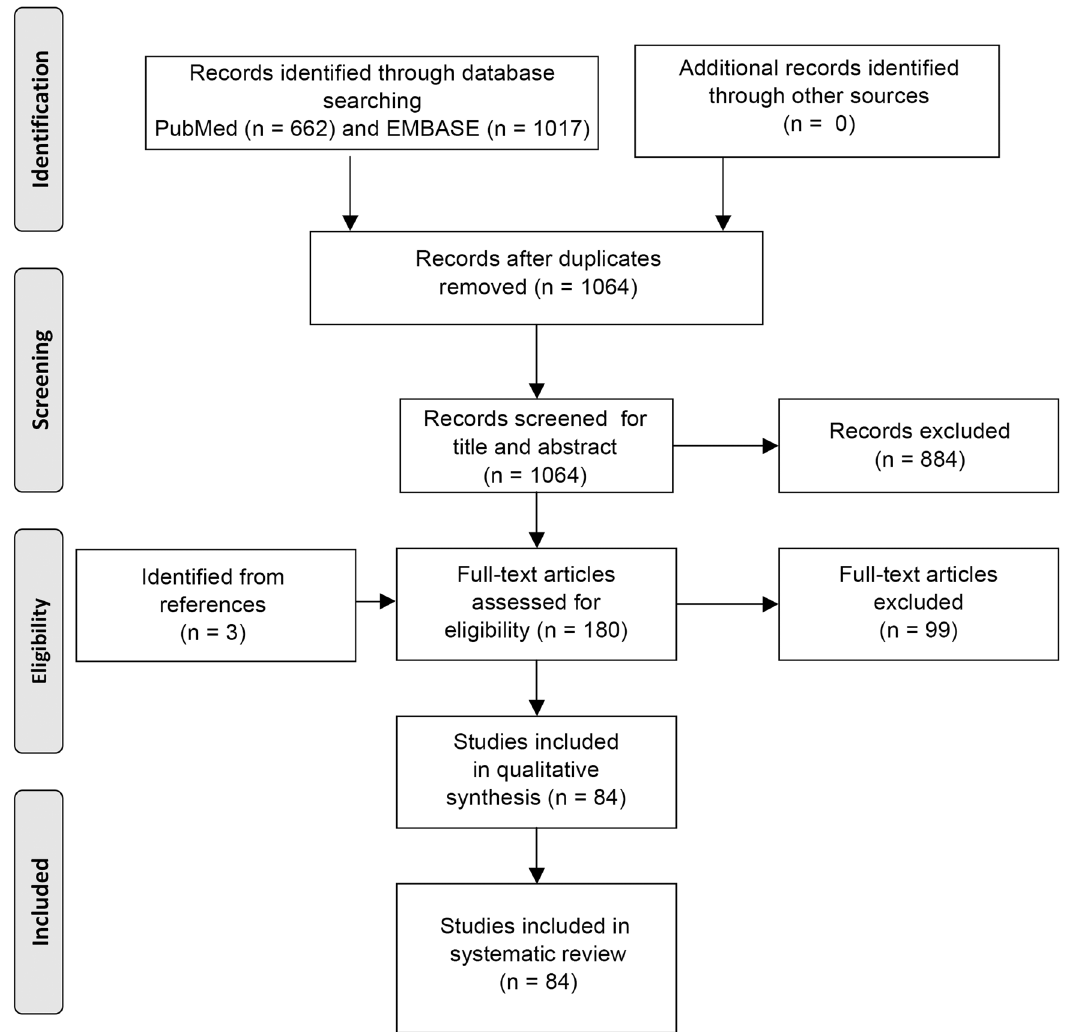
Fig. 1 Flow diagram of the literature search. Preferred Reporting Items for Systematic Reviews and Meta-Analyses (PRISMA) work fl ow showing systematic selection process for